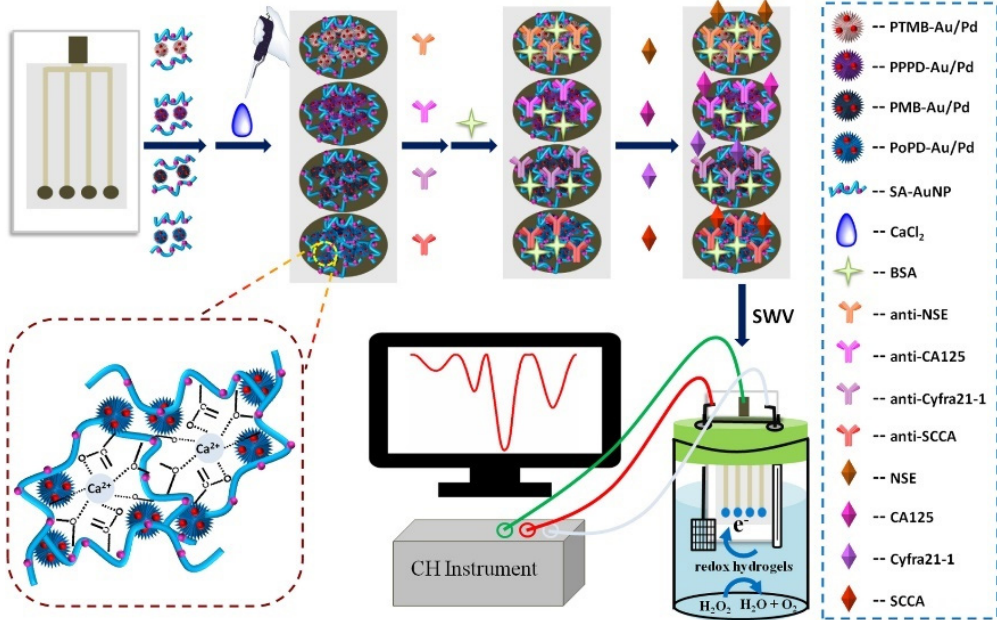
Figure 9. Label-free amperometric detection of four tumor biomarkers using specific hydrogel activation for each biomarker, with multiple working electrodes on a SPCE. Reprinted with permission from [122], copyright 2017 Elsevier B.V.